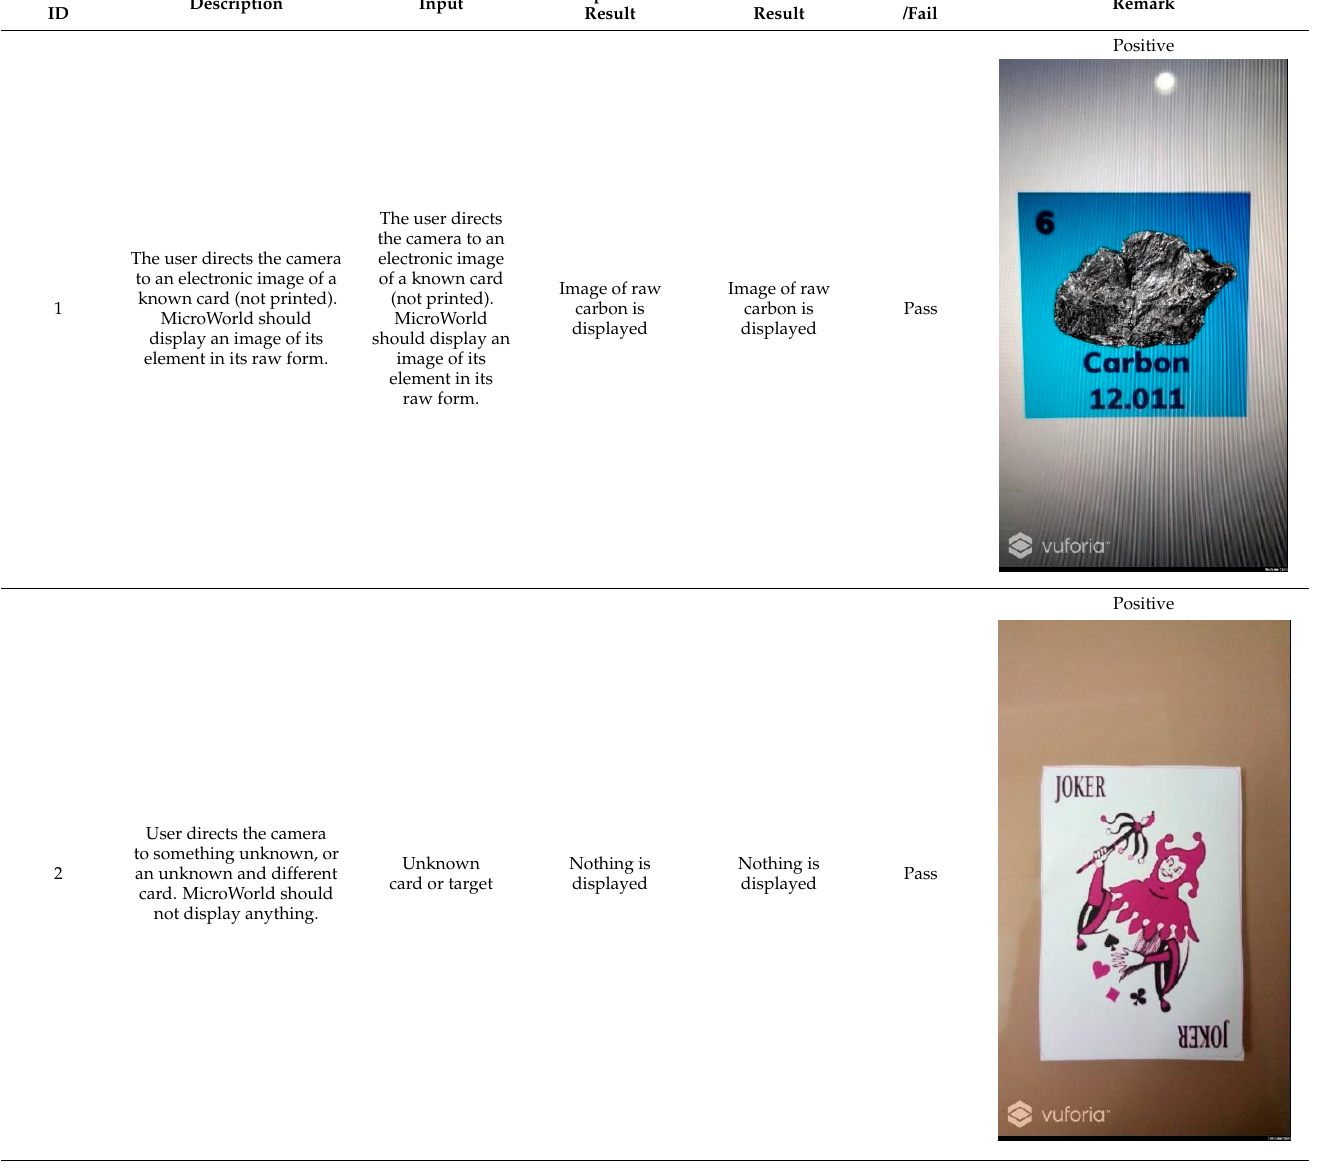
Table A1. Unit testing cases of showing the chemical element in substantial nature